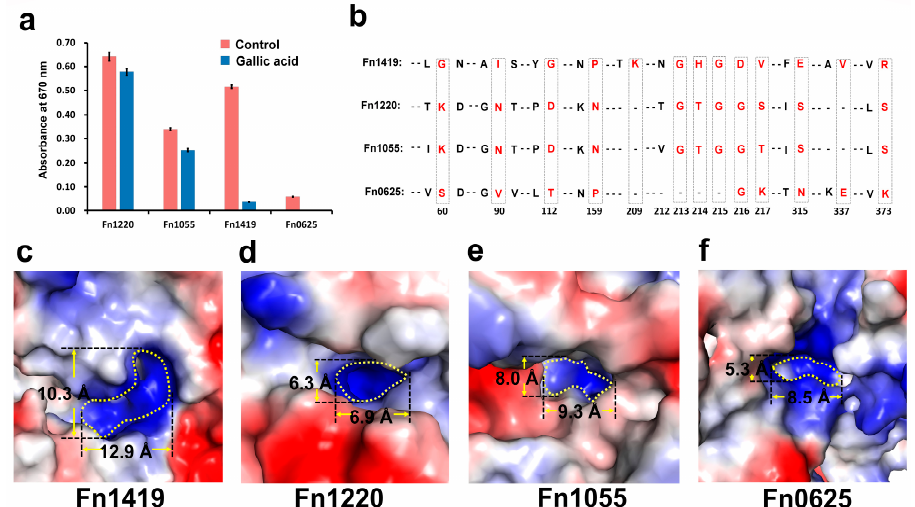
Figure 5. Putative gallic acid-binding sites on Fn1419. ( a ) The inhibitory effect of gallic acid on Fn1220, Fn1055, Fn1419, and Fn0625. The error bars represent the standard deviation of three replicates. ( b ) Partial sequence alignment of the active sites of Fn1220, Fn1055, Fn1419, and Fn0625. The numbering reflects Fn1419 numbering. The identified PLP- and gallic acid-binding residues are boxed and shown in red. ( c – f ) Electrostatistic surface of the PLP- and substrate-binding pockets of Fn1419 (PDB ID: 7BQW), Fn1220 (5XEO), Fn1055 (5B53), and Fn0625 (predicted by AlphaFold).